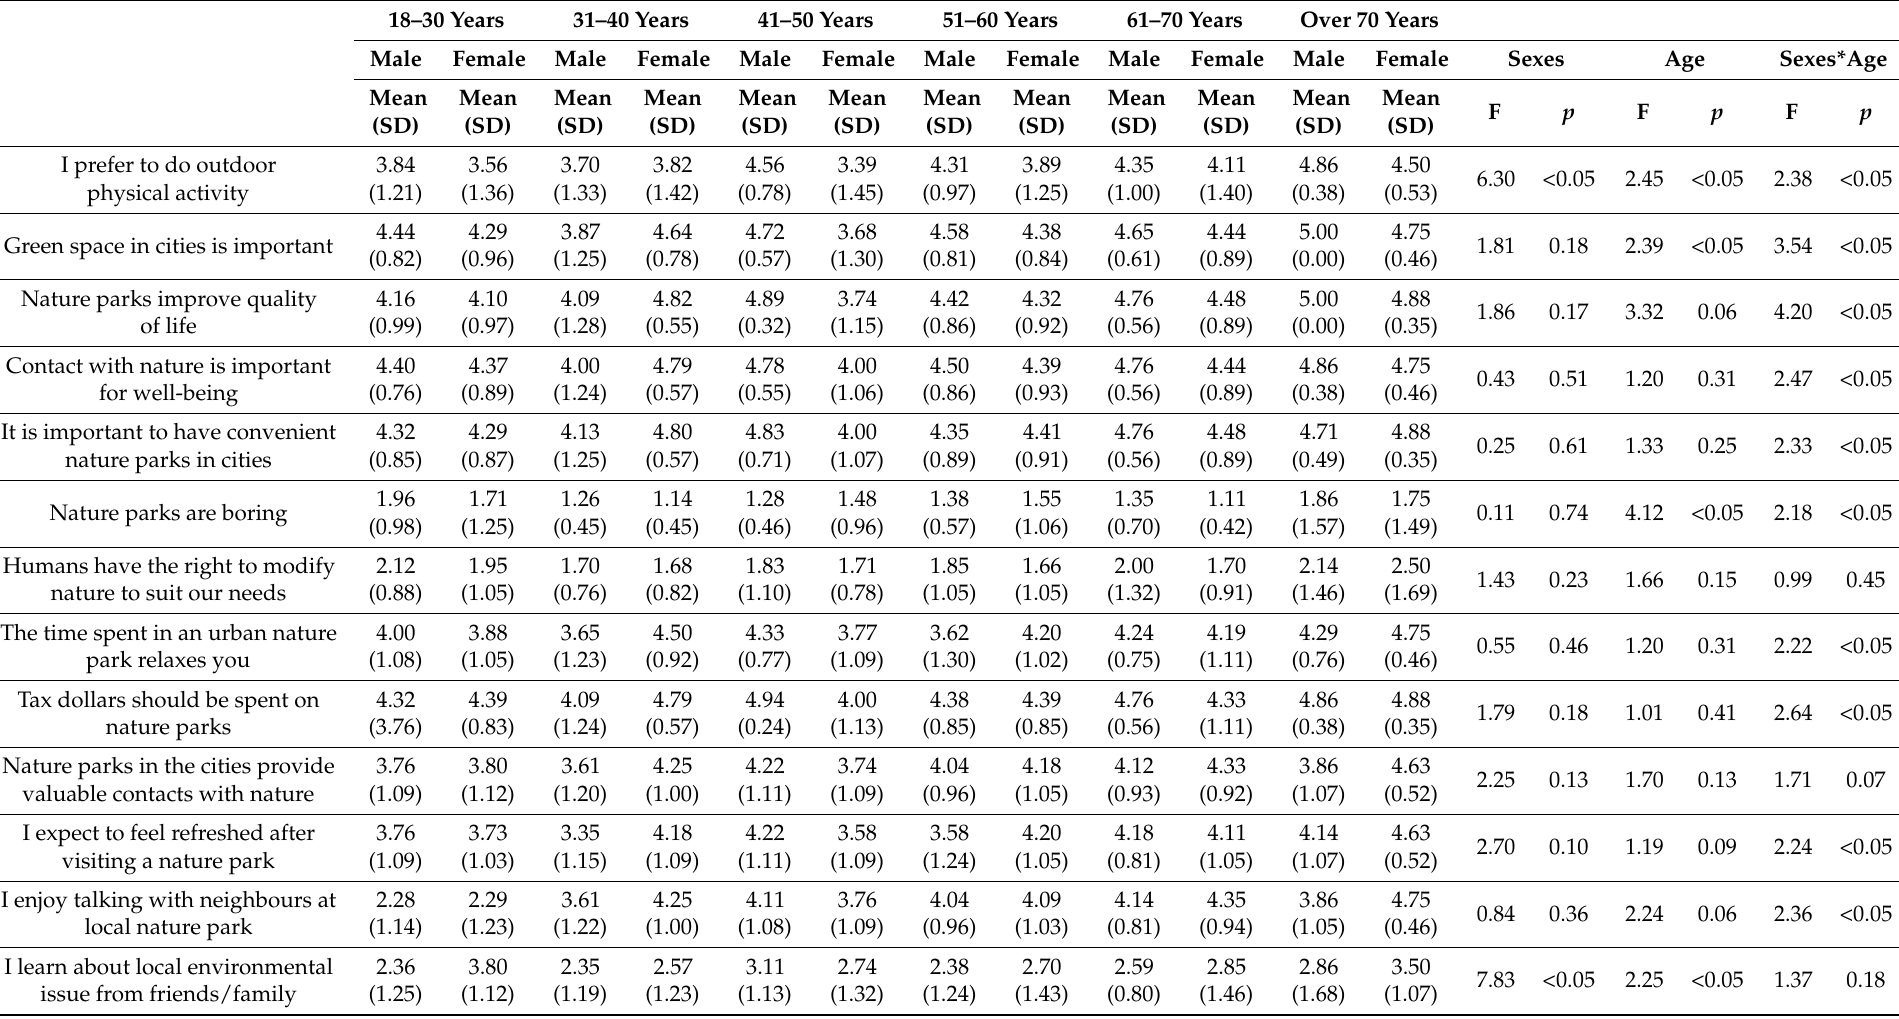
Table 3. Descriptive statistics and ANOVA for sexes and age